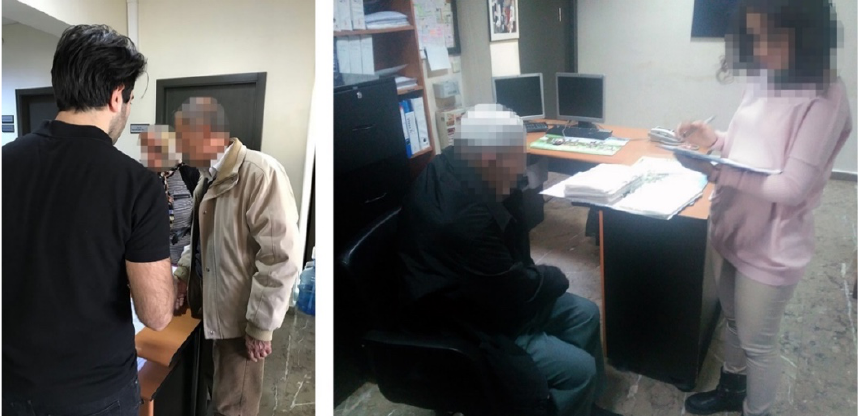
Figure 8: Interview with doctors and